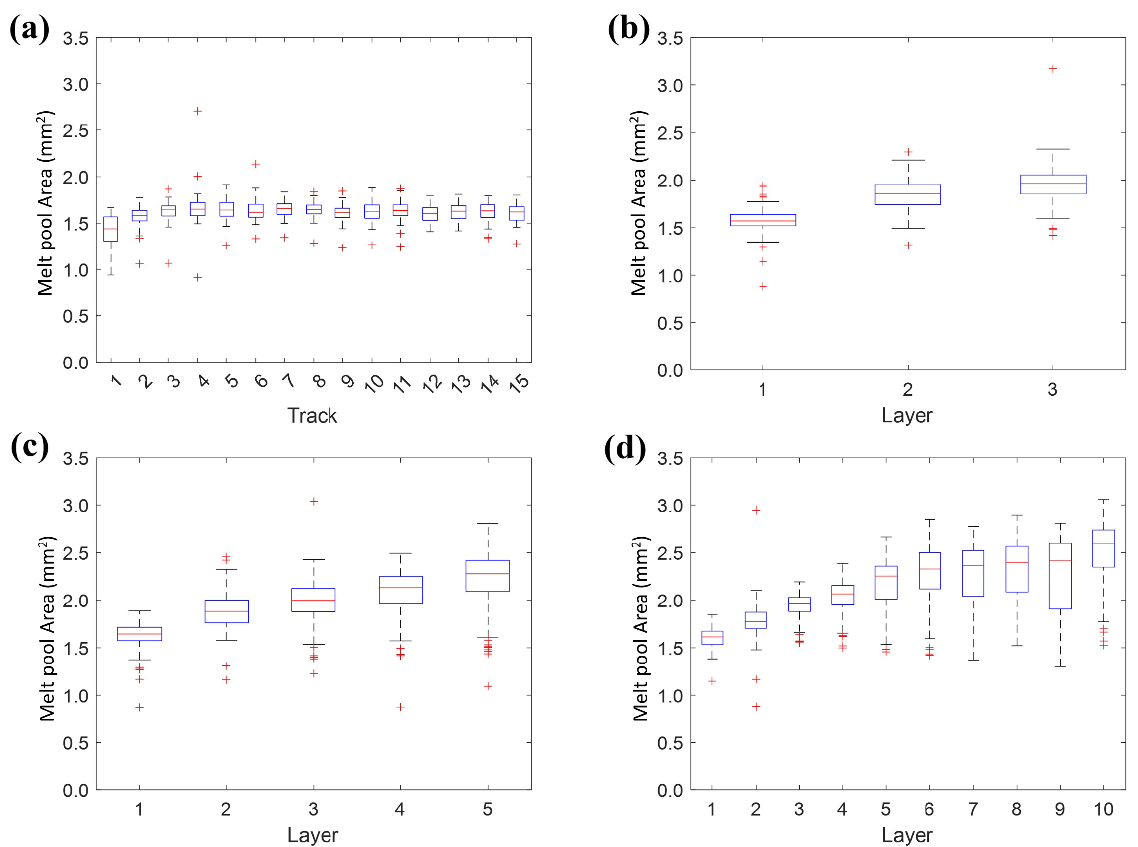
Figure 6. Trend of the melt pool area. ( a ) Sample 1_C, ( b ) Sample 3_C, ( c ) Sample 5_C, ( d ) Sample 10_C (c).